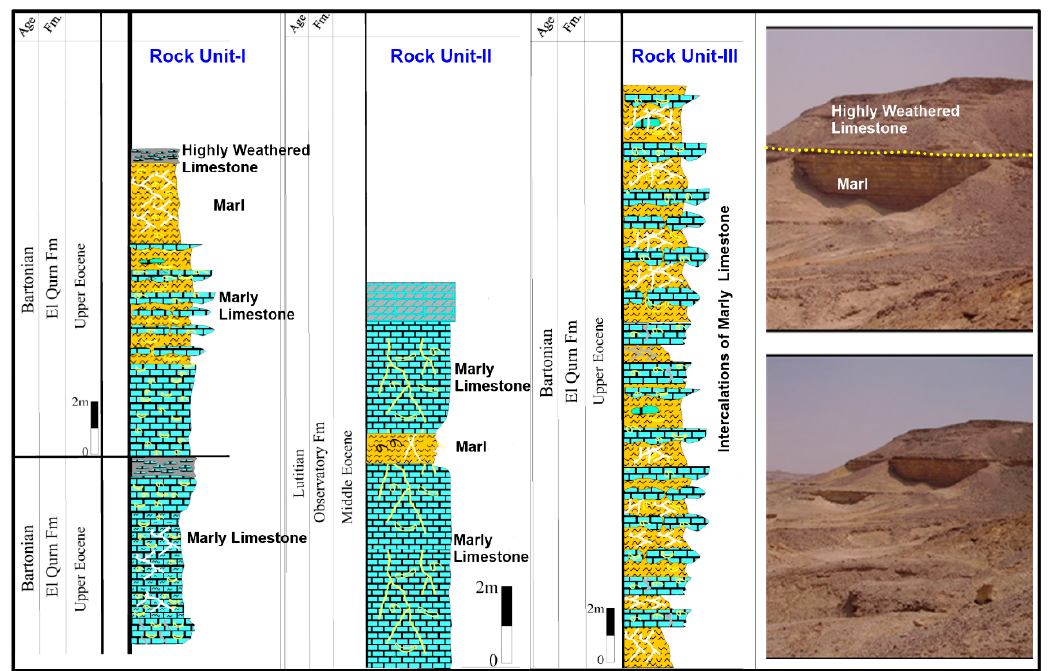
Figure 4. Stratigraphic cross-section of Qurn formation and the related field photos.